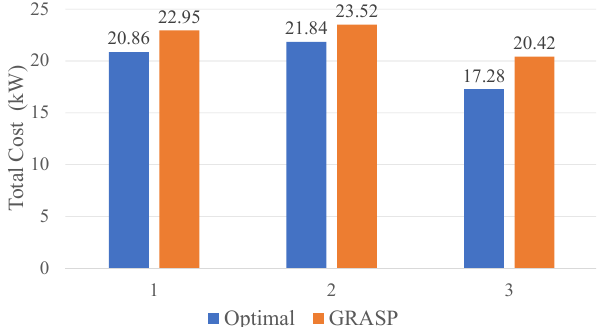
Figure 11. Comparison of power costs achieved by the optimal method and GRASP on the IEEE14 bus system.